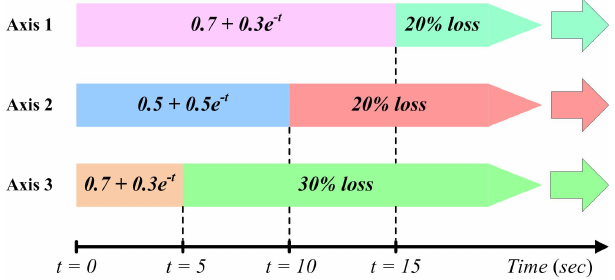
Figure 2. Multiplicative fault in the actuator.